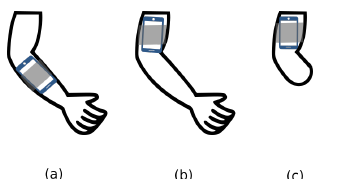
Figure 8. Smartphone Positioning. Source: Author (2022).